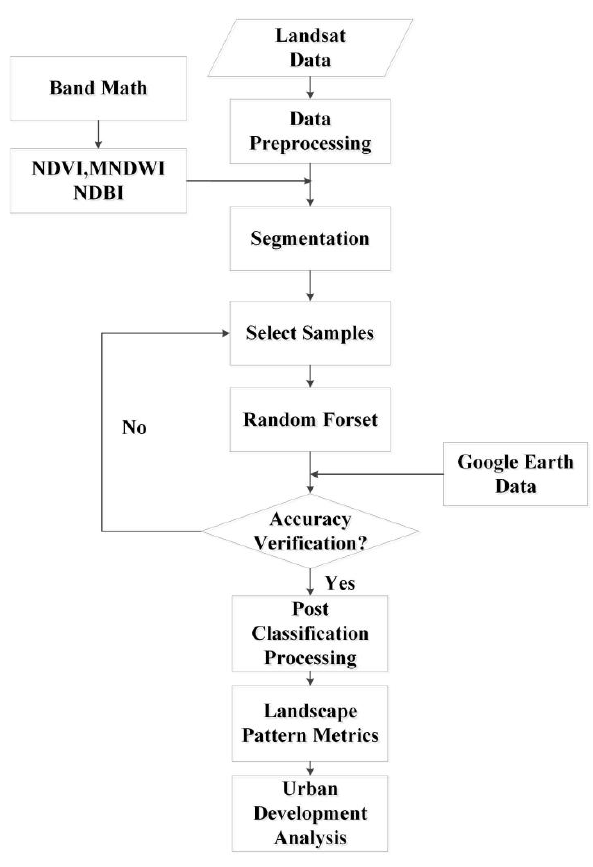
Figure 2. Technical flow